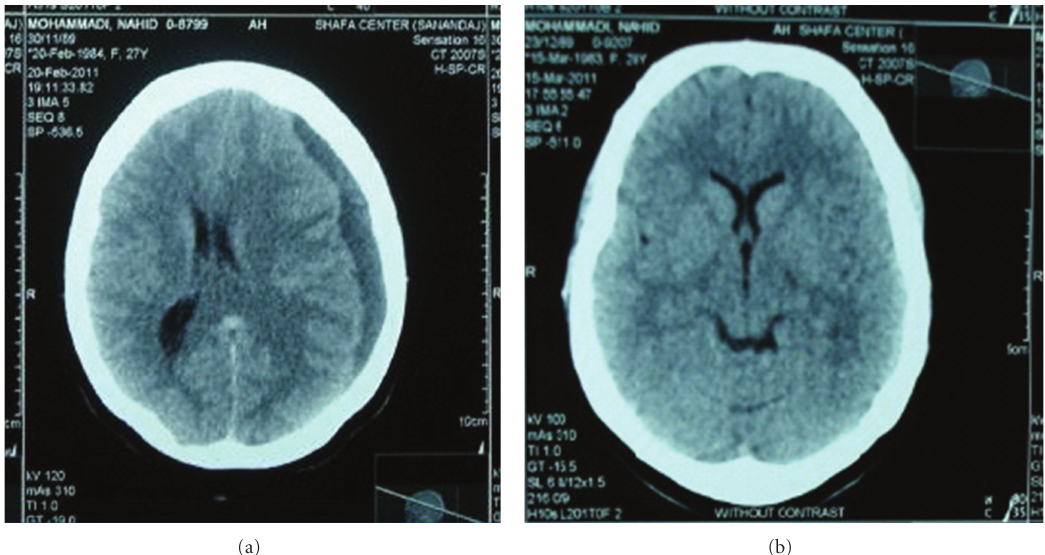
Figure 1: (a) Brain computed tomography scan showed a late subacute SDH of the left frontotemporal region and midline shift. (b) Normal control Computed tomography scan.